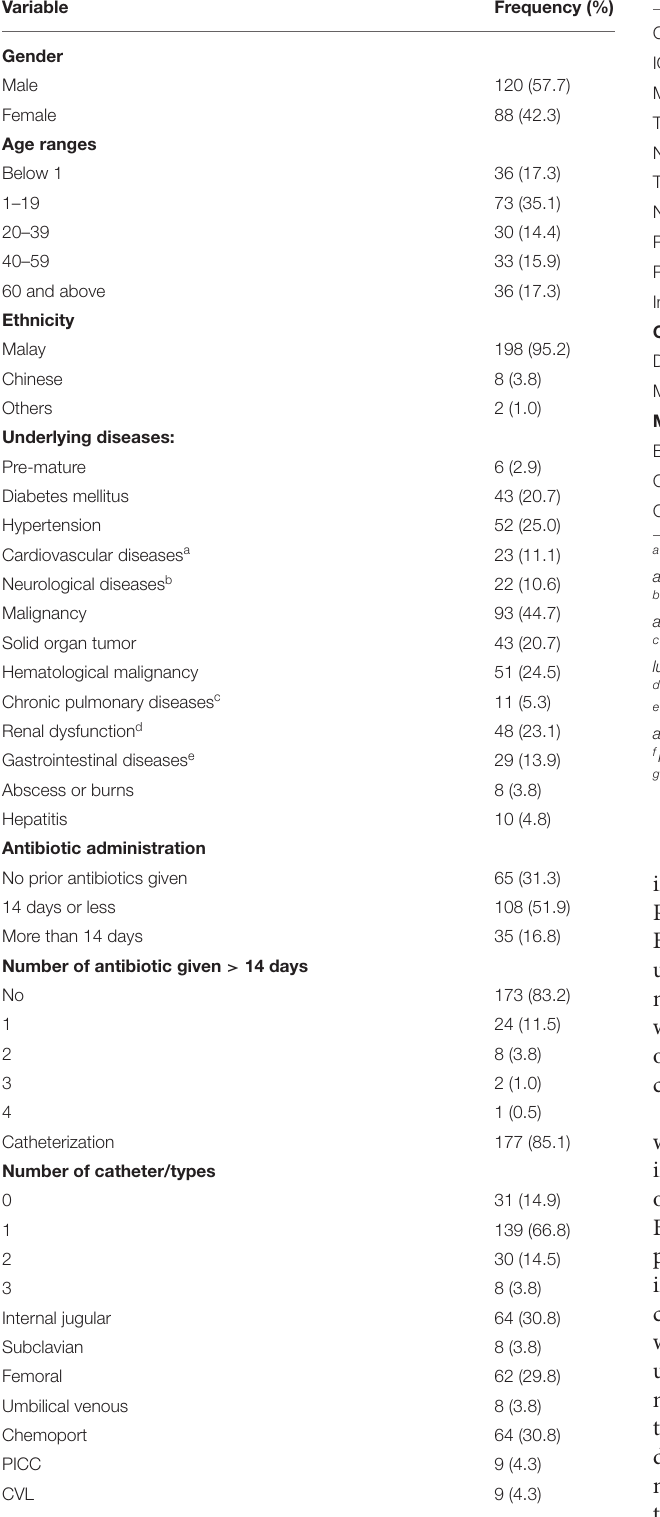
TABLE 1 | The demographics, clinical characteristics, and predisposing factors of 208 patients with Candida parapsilosis candidemia.